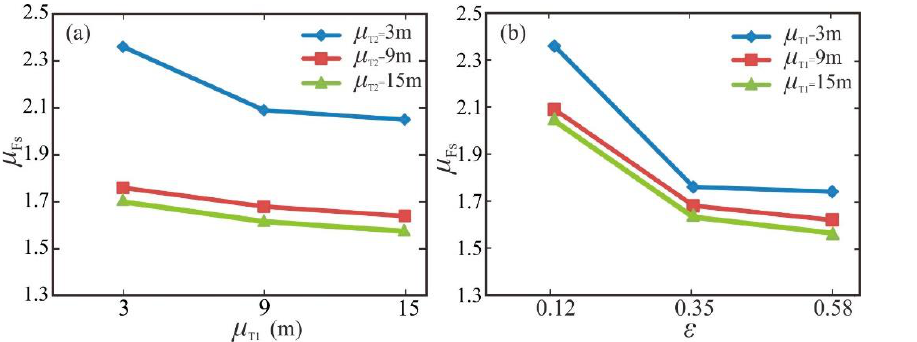
 increases; b- increases; ( b )—the 1 1 T to slope height H  to slope height H. 2 2 T